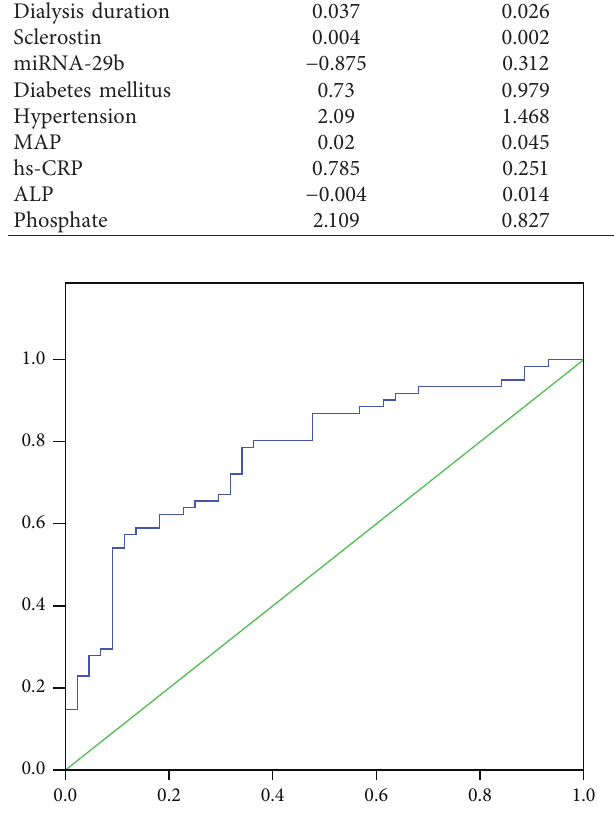
Figure 2: Receiver operating characteristic curves for prediction of CAC by serum levels of